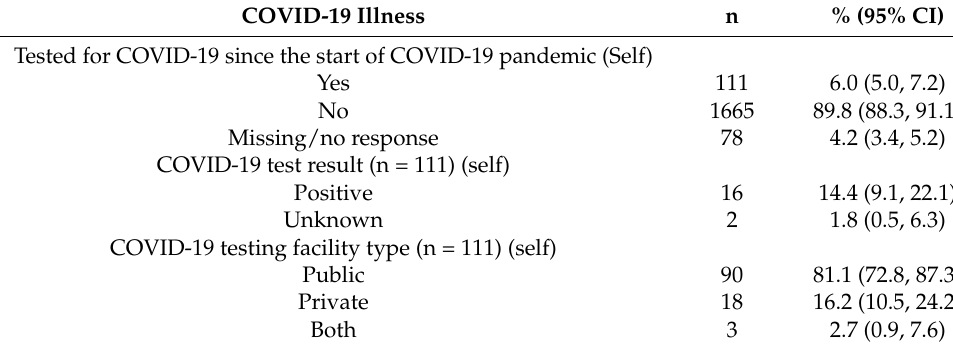
Table 5. COVID-19 illness among the general population during the COVID-19 pandemic in